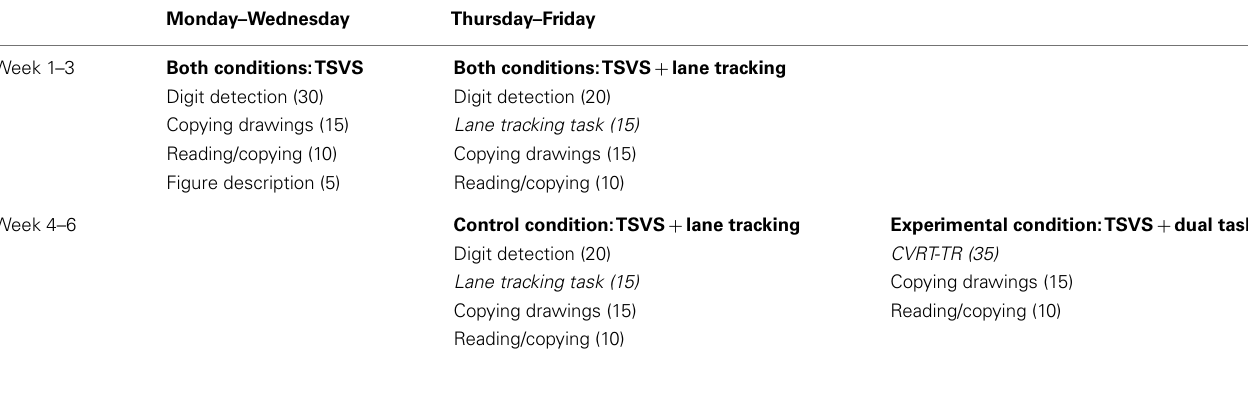
Table 2 |Training schedule for both